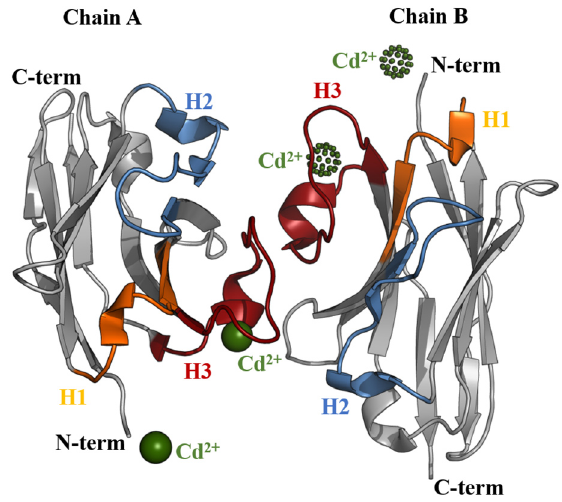
Figure 5. Ribbon diagram of the crystal structure of BCD090-M2 in space group P1 at 1.9 Å resolution (PDB:6F0D). Asymmetric unit contains two copies of the VHH antibody and two cadmium ions which are pictured as green spheres, two symmetry-related ions from the neighbor unit cell are shown in dots. Framework regions are grey and CDRs are colored.